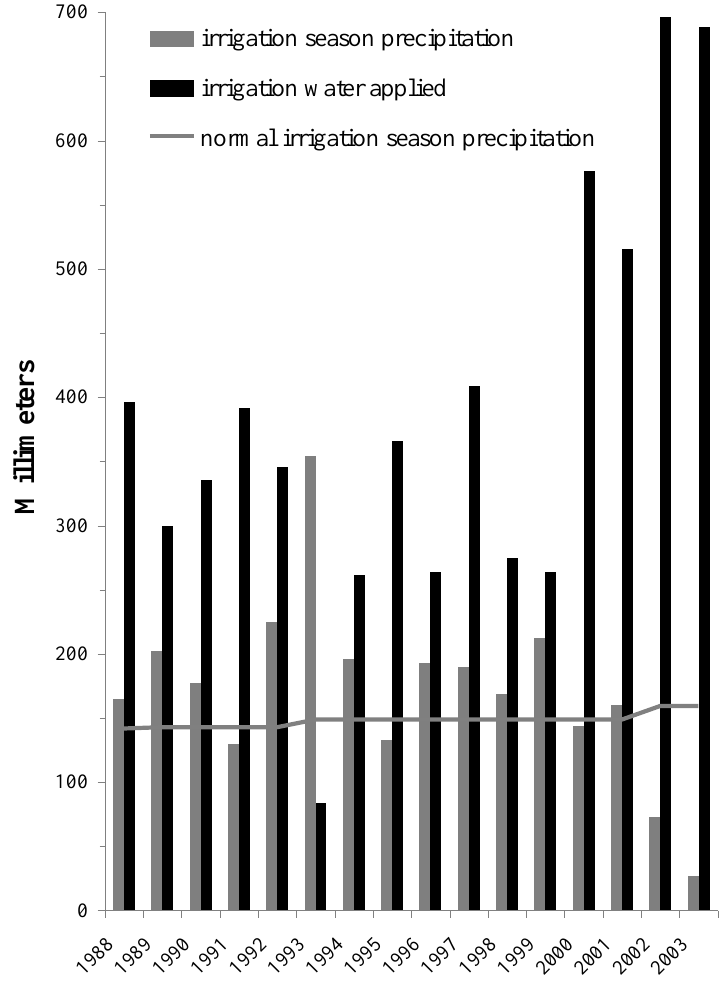
FIGURE 5. Irrigation season (July and August) precipitation and irrigation water application. Kearney and Grand Island station data[28] were averaged to obtain the irrigation season and normal irrigation season precipitation for the study